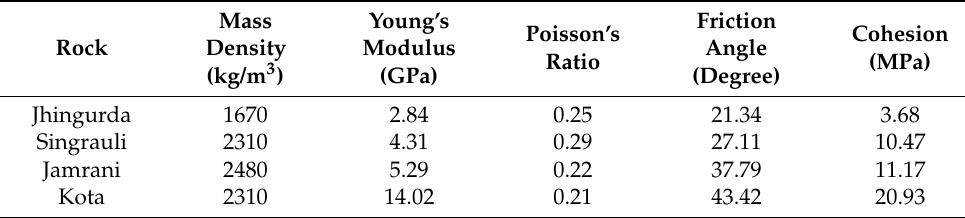
Table 1. Four different sandstone rock surrounding the tunnel opening.